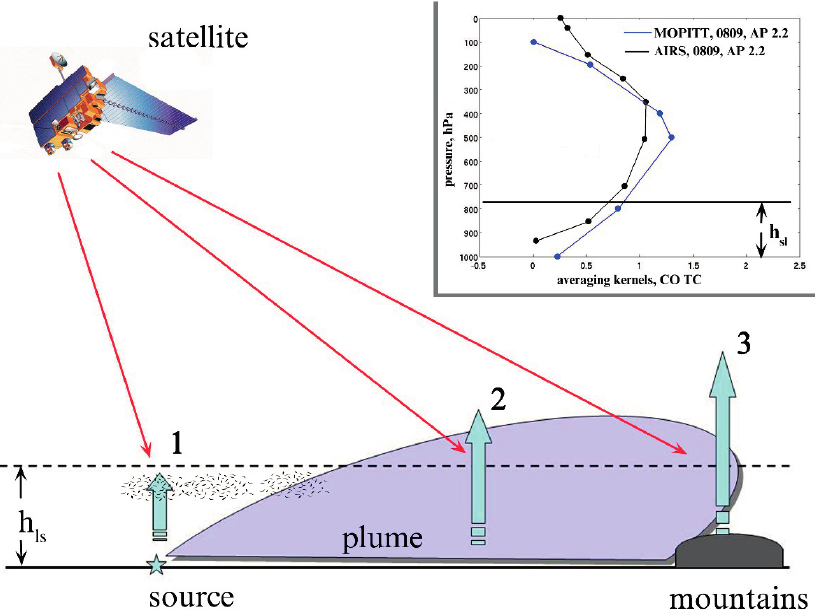
Figure 14. The scheme explained why the satellite sensitivity depends on satellite scanning locations. Dashed line shows the h sl level, below which the satellite sensor MOPITT has a low sensitivity; h sl ~2 km. A PBL values are shown as blue arrows. On the plate the typical average kernels of CO total column for MOPITT and AIRS sensors were shown in